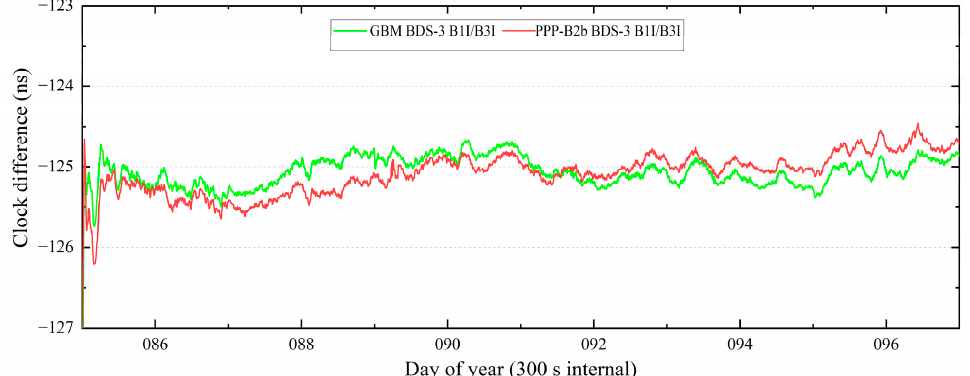
Figure 13. Clock difference of UTC(NTSC)-UTC(TL) using the PPP-B2b product and the GBM product via PPP.